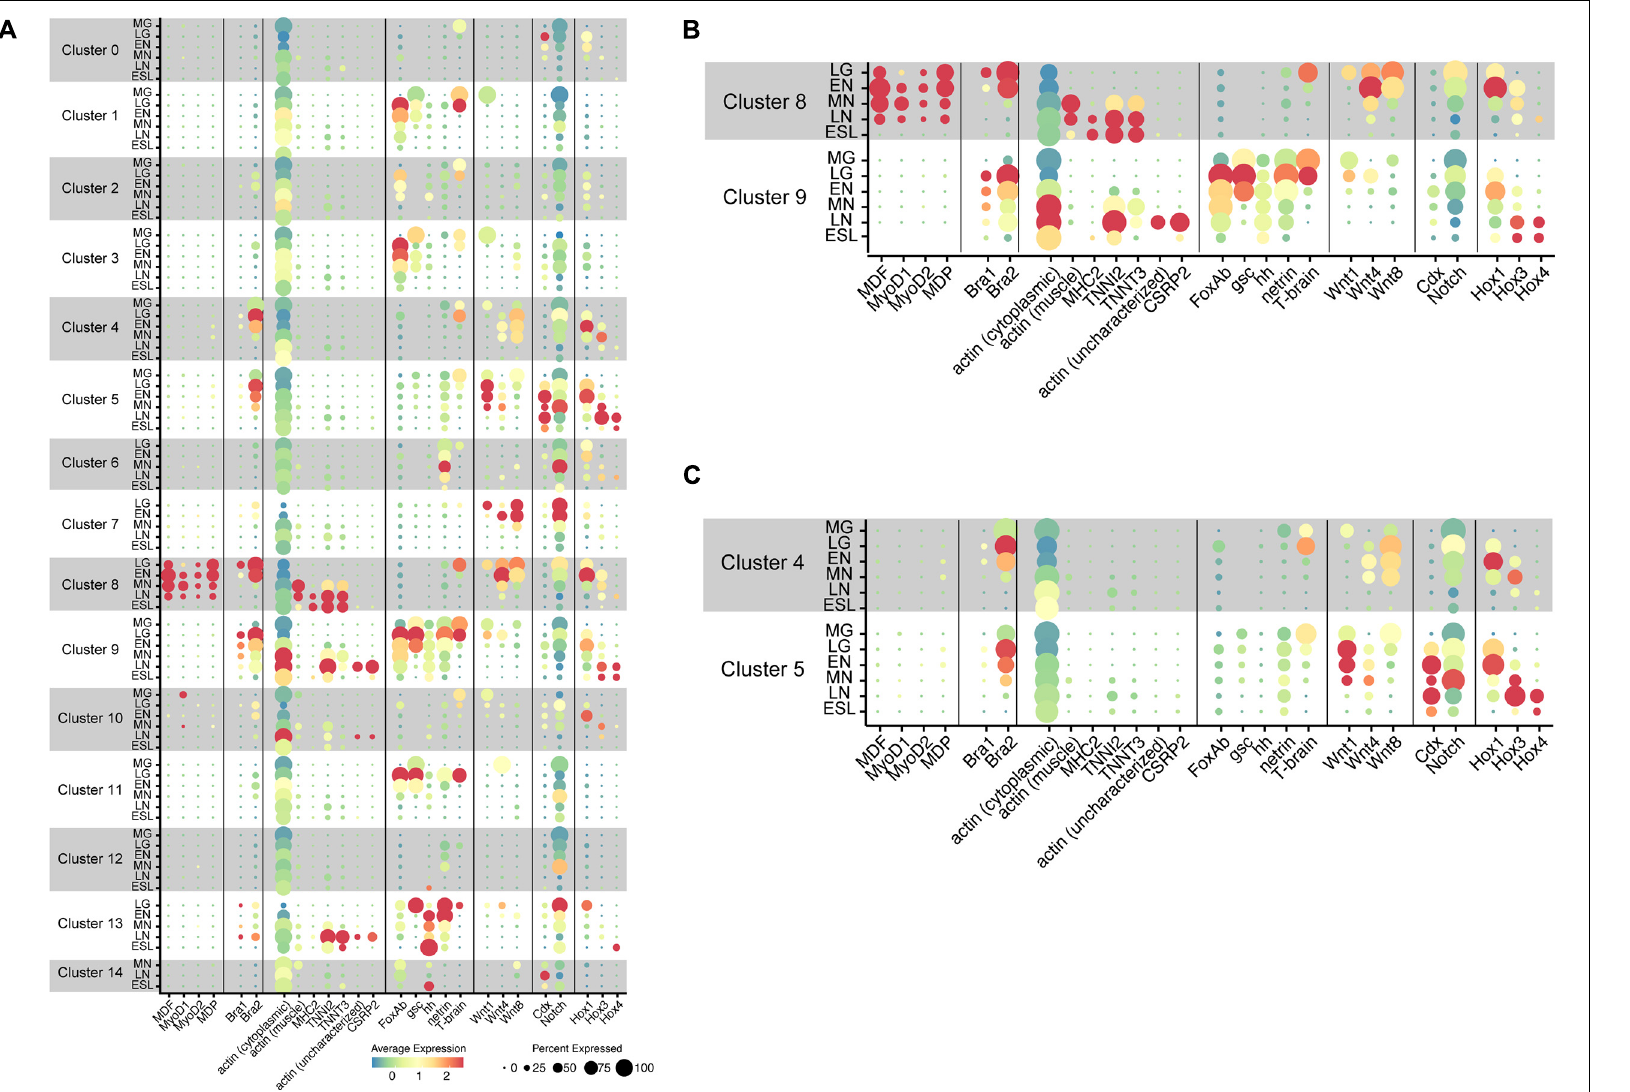
FIGURE 4 | Transcriptome trajectories for 15 clusters comprising early stages of Branchiostoma japonicum embryos. Dot size represents the percentage of cells that express genes for transcription factors, signaling molecules, and structural proteins. Dot color shows the averaged level of expression. MG, midgastrula; LG, late gastrula; EN, early neurula; MN, midneurula; LN, late neurula; ESL, early swimming larva. (A) A summary figure. (B) Enlargement of clusters 8 and 9. (C) Enlargement of clusters 4 and